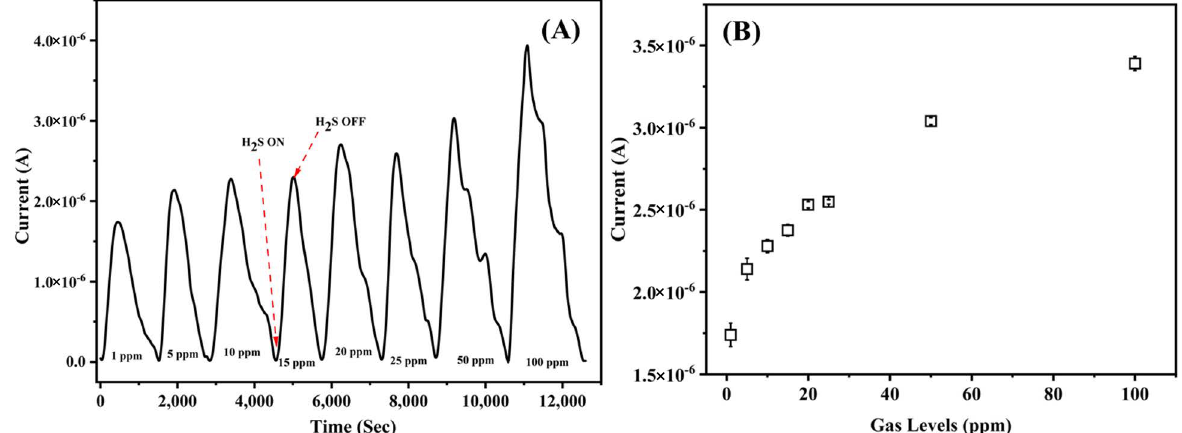
Figure 6. ( A ) Current response of the Cu-MOF/PVA/IL membrane with respect to time and H 2 S concentration measured at room temperature. ( B ) Response of the sensor for corresponding gas concentrations.